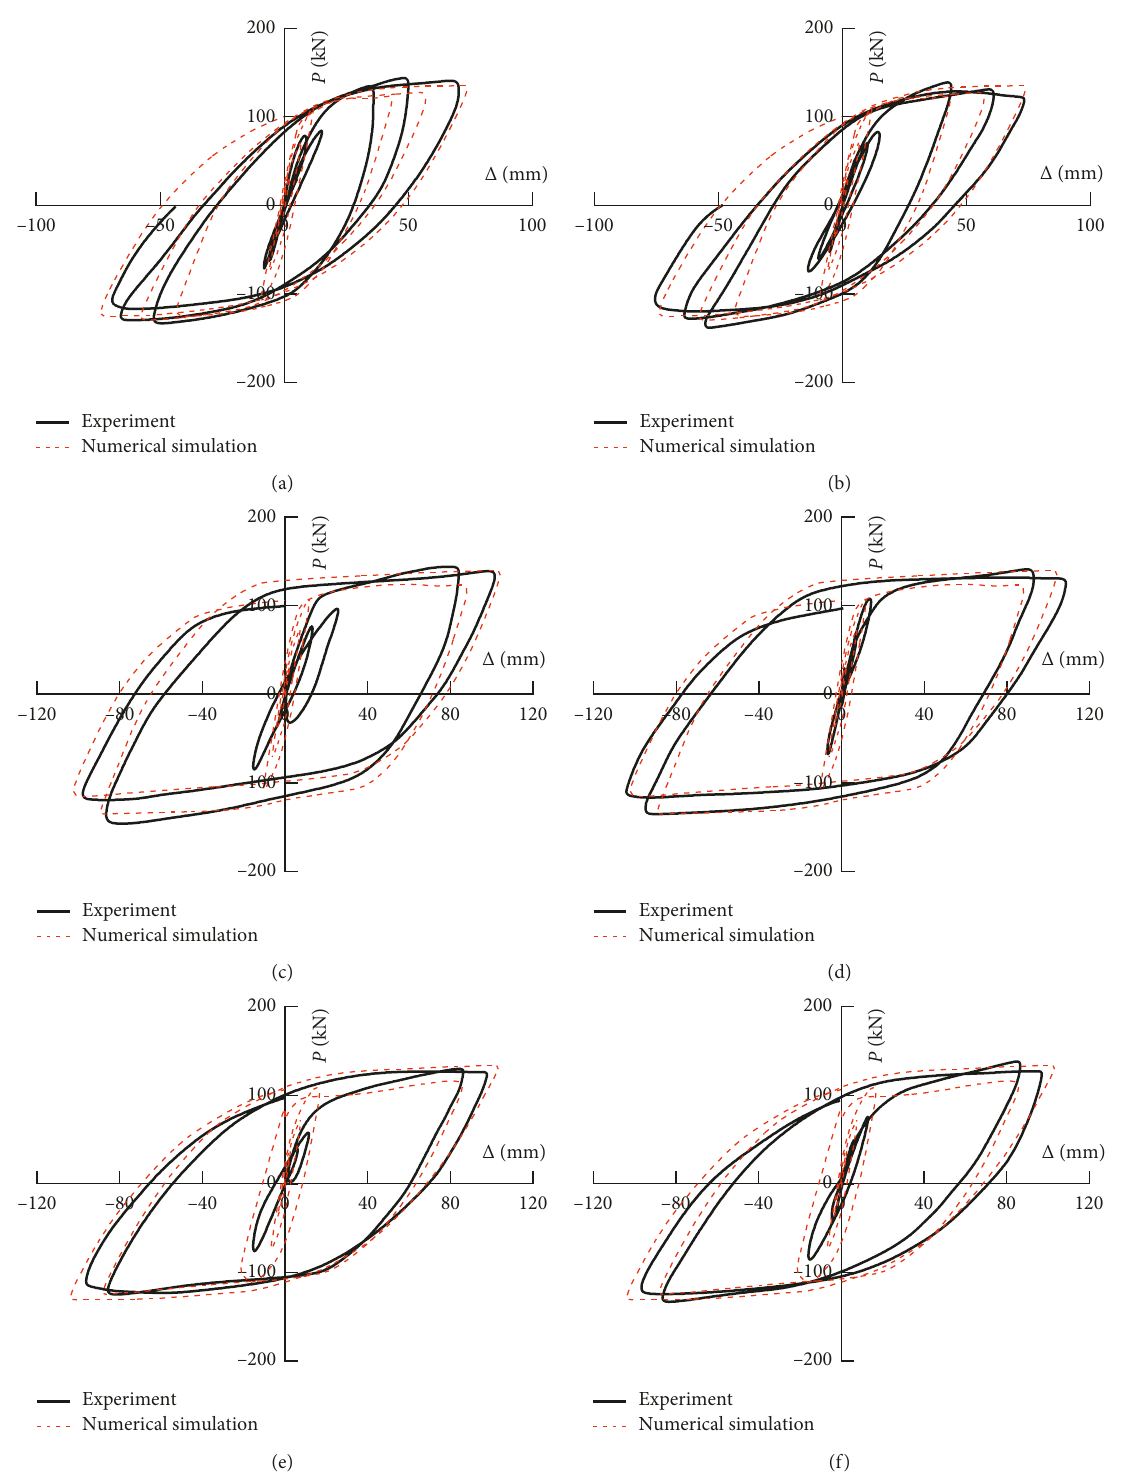
Figure 8: Comparison on load-displacement hysteretic loops between FEA results and experiment results. (a) Specimen A1. (b) Specimen A2. (c) Specimen B1. (d) Specimen B2. (e) Specimen C1. (f) Specimen